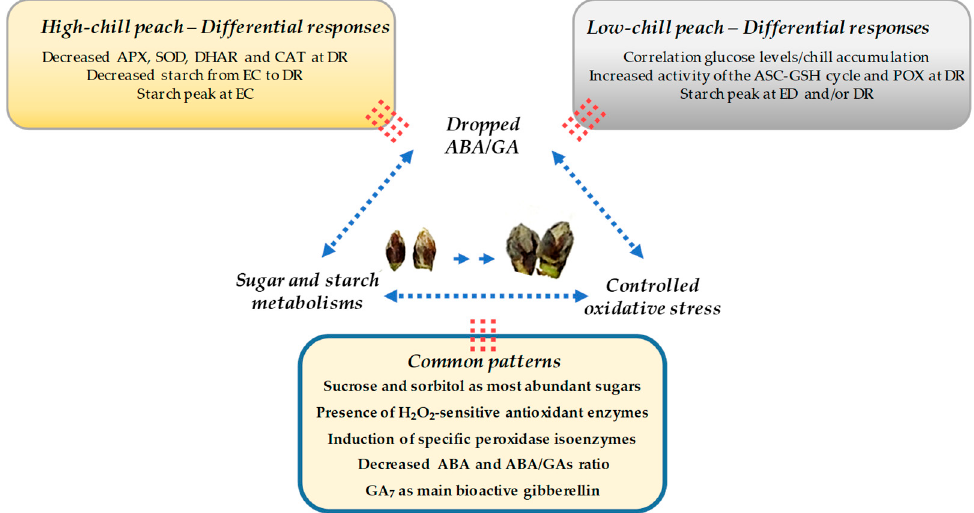
Figure 20. Comparative scheme of the physiological events occurring in peach buds during dormancy evolution and release. The differential responses and the common patterns for a high-chill (this study) and a low-chill peach variety [26] are shown. In synthesis, an interplay among a controlled oxidative stress, changes in sugar and starch metabolisms, and decreased ABA/GAs ratio is proposed to